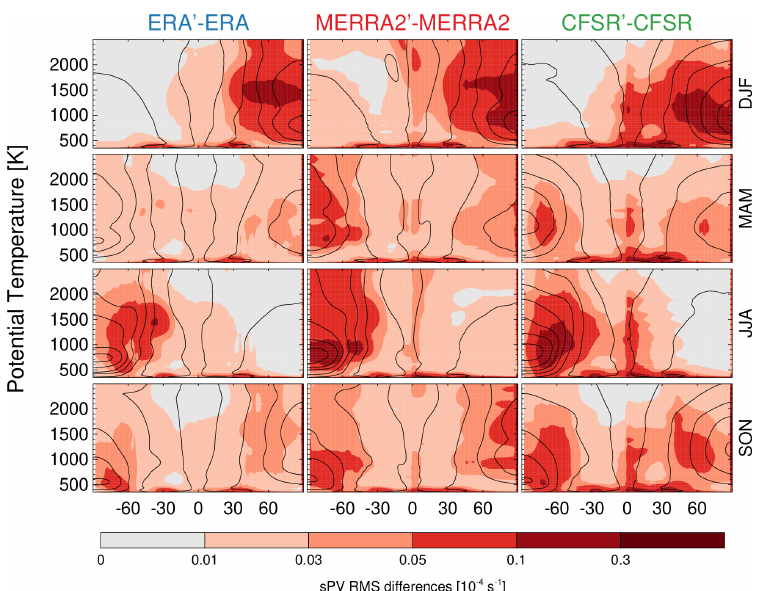
Figure A2. Seasonal root-mean-square (RMS) daily (1980–2014) sPV differences between the sPV from each reanalysis provided vorticity or PV and the sPV computed from that reanalyses’ horizontal wind, pressure, and temperature fields. Overlaid contours show each reanalyses’ climatology based on that reanalyses’ provided